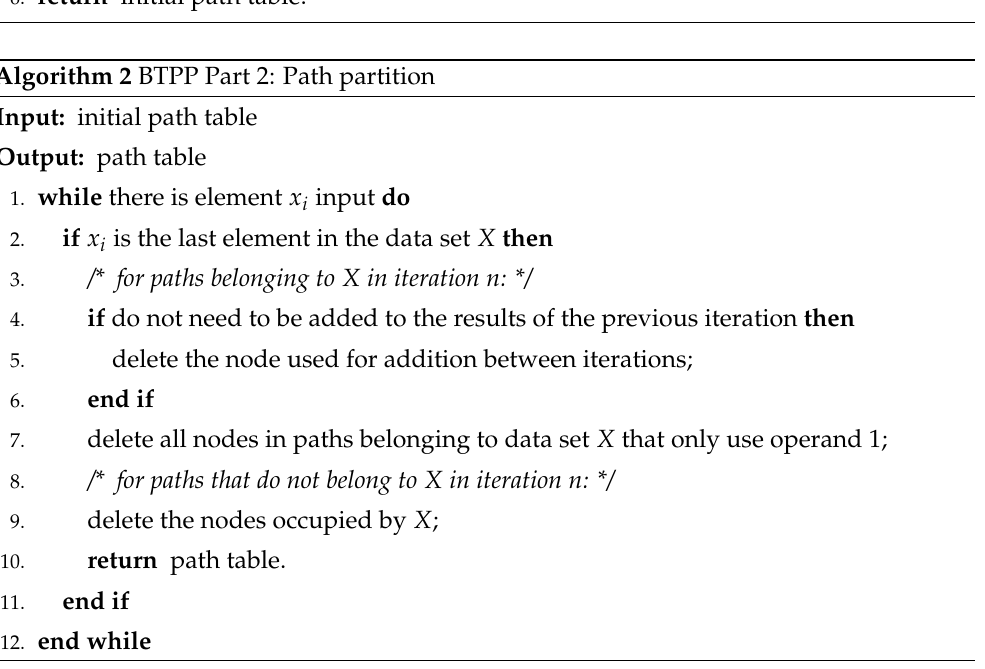
Algorithm 2 BTPP Part 2: Path